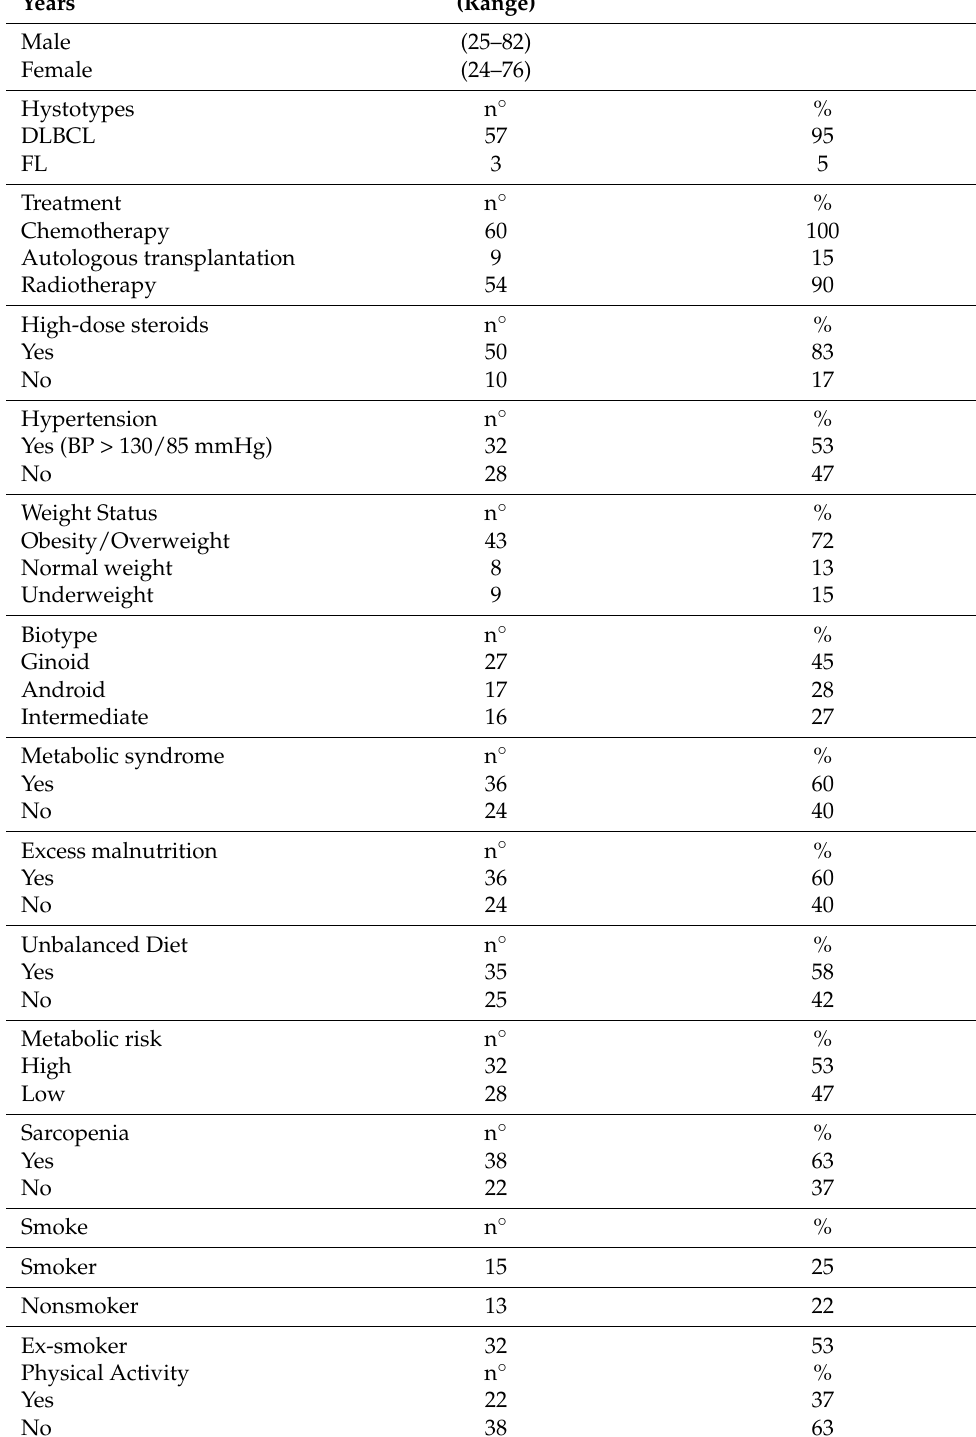
Table 1. Baseline clinical- anthropometric and lifestyle characteristic of 60 NHL